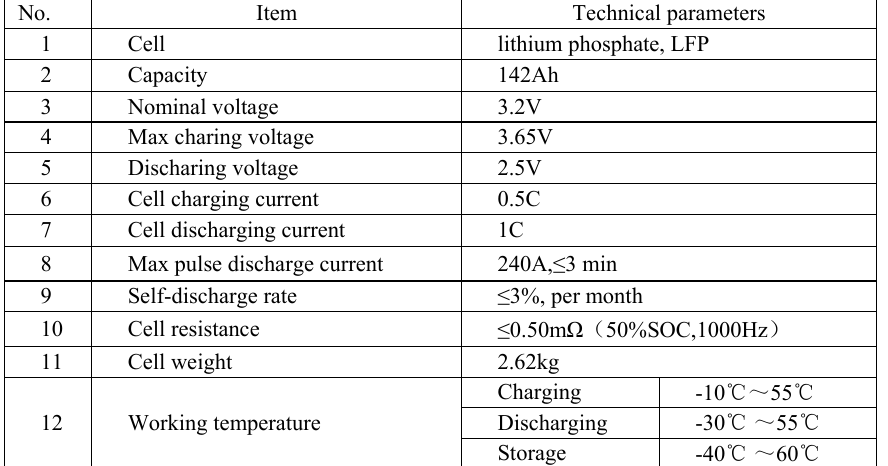
Table 2. Battery cell